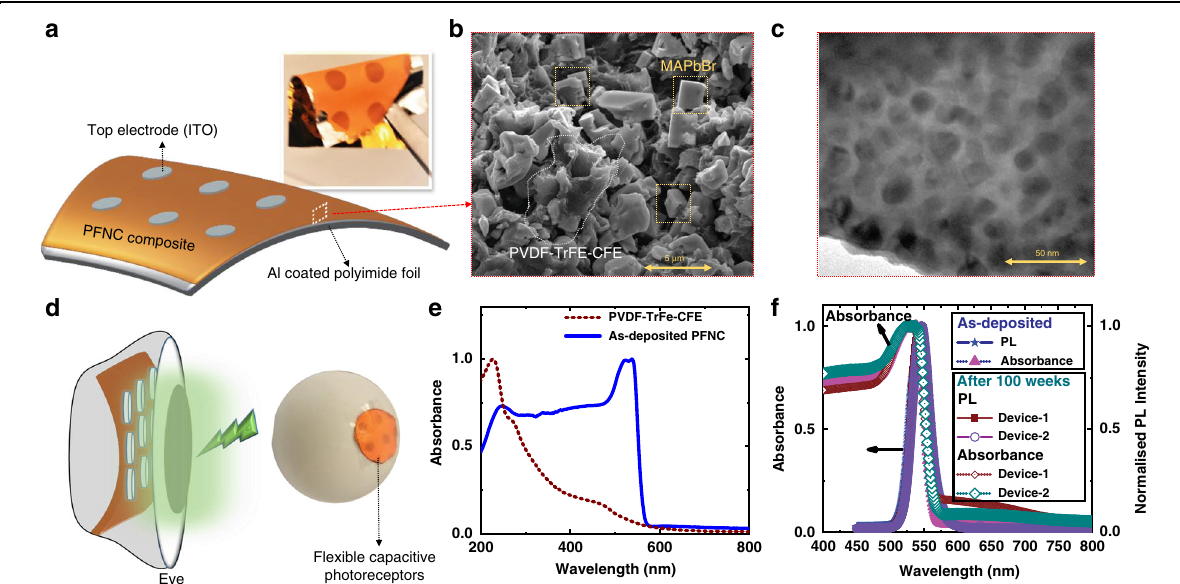
Fig. 2 The fl exible capacitive photoreceptors (CPRs) and material characterization. a Schematic of the fl exible CPR showing the perovskite ferroelectric nanocomposite (PFNC) sandwiched between transparent top electrodes indium tin oxide (ITO) and aluminum (Al) coated polyimide substrate. (Inset shows the fabricated device). b The cross-sectional scanning electron microscope (SEM) image of the PFNC thin- fi lm. c Transmission electron microscope image of the PFNC showing the perovskite nanocrystals embedded in the polymer. d Representative schematic to depict that fl exible capacitor as photoreceptors of the retina and the digital photograph of the fl exible CPRs array shaped into hemispherical form. e UV − VIS absorbance spectra of perovskite ferroelectric polymer nanocomposite (PFNC) and the ferroelectric polymer. f Absorbance and photoluminescence spectra of the as-deposited PFNC and devices after 100 weeks of fabrication, con fi rming the stability of the CH 3 NH 3 PbBr 3 in the